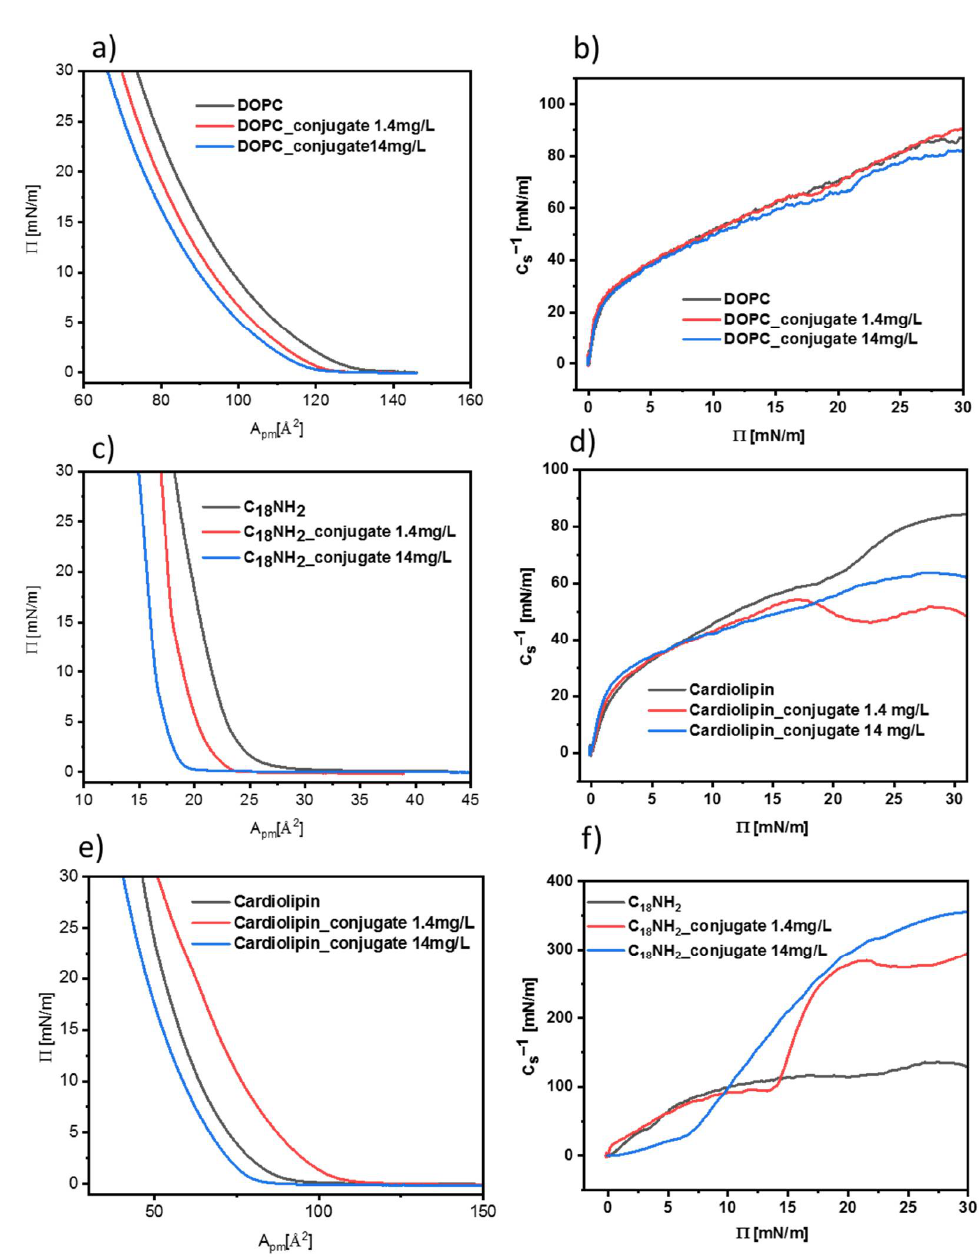
Figure 9. Langmuir isotherm and compressibility coefficient of DOPC ( a , b ), C 18 NH 2 ( c , d ), and cardiolipin ( e , f ) membranes in the presence and absence of conjugate. (concentration of IONP@CA_GMP_Tb 3+ 1.4 and 14 mg/L-marked in the graph).